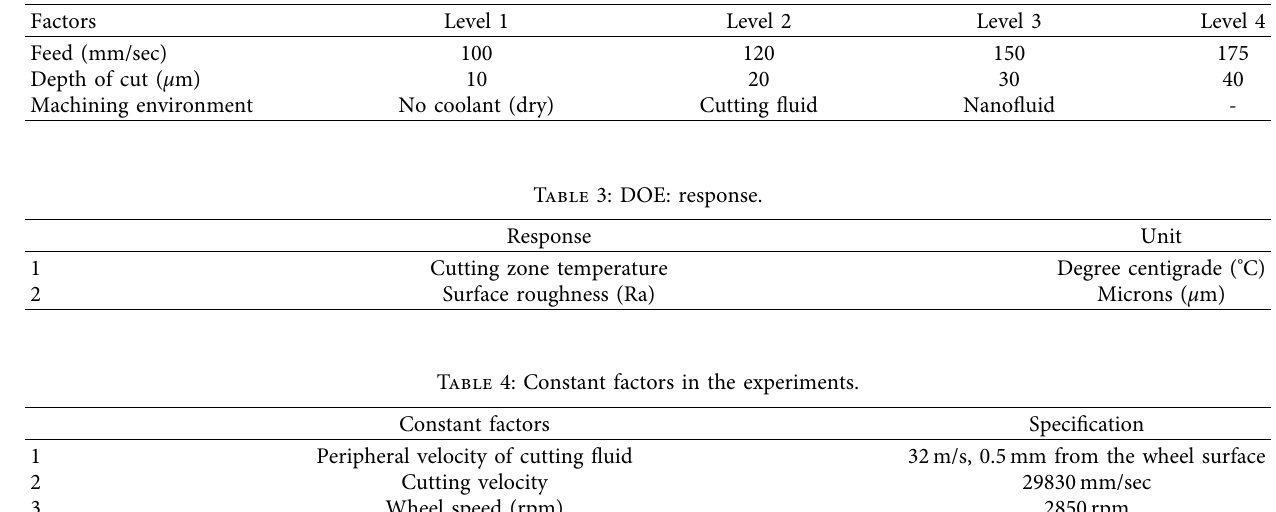
Table 2: DOE: factors and amp—levels.